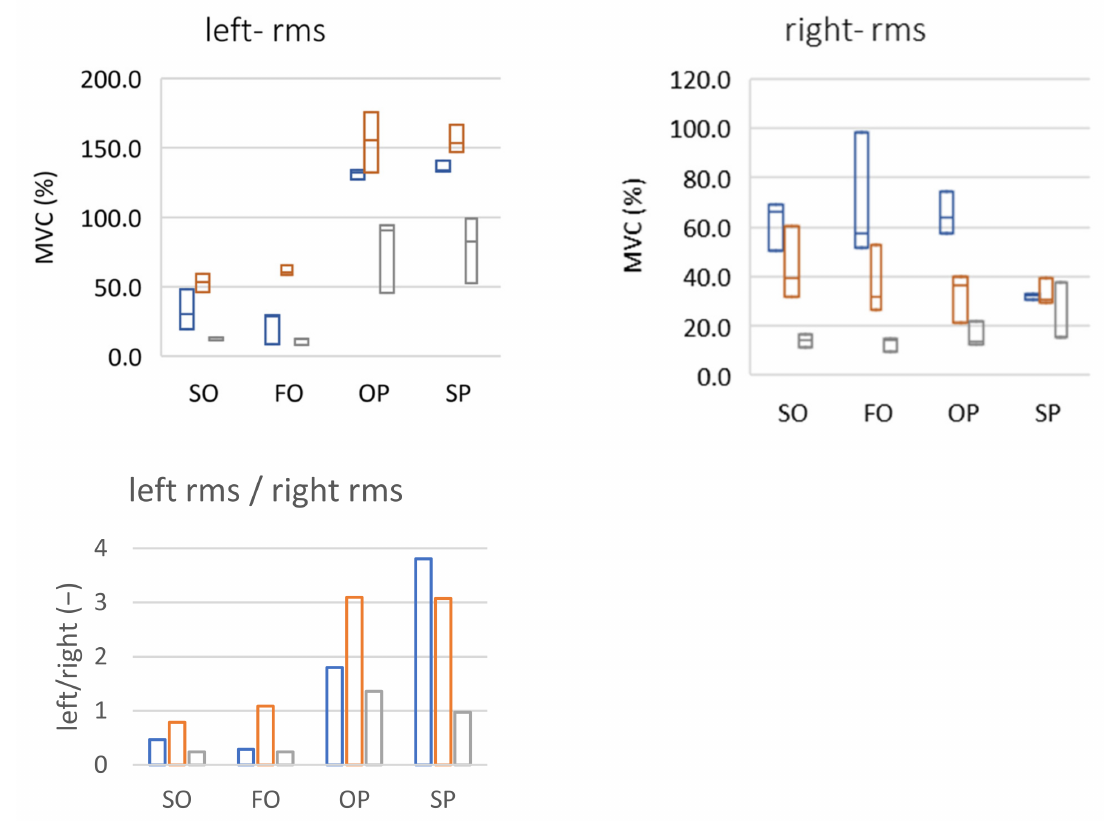
Figure 11. MVC of sEMG signals. Top row: left and right side (max-median-min); bottom row: the quotient of the left and right sides (mean). SO (slow opening), FO (fast opening), OP (opening with protruding), SP (slow